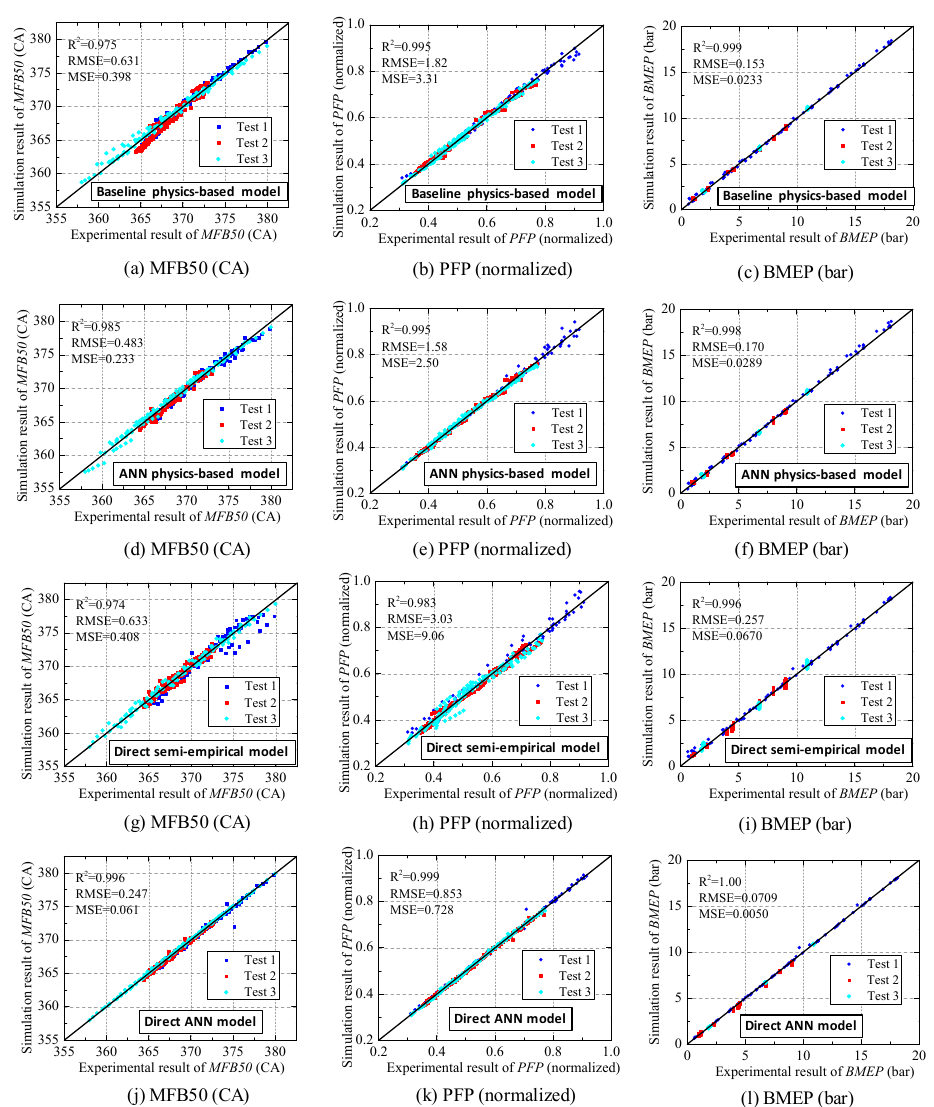
Figure 6. ( a – l ) Comparison of the performance of the developed models under steady-state operating conditions.